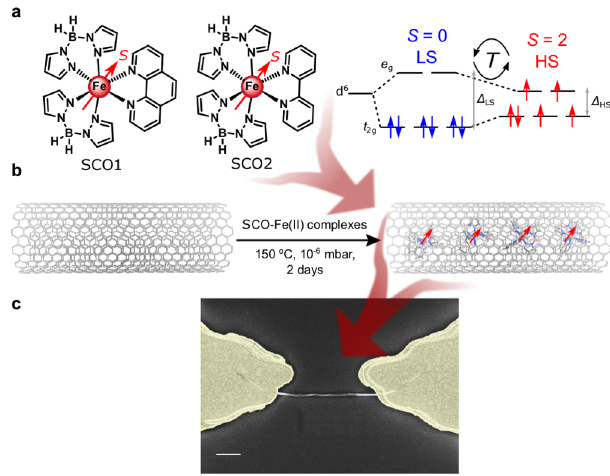
Fig. 1 Encapsulation of SCO complexes. a Complex SCO1, [Fe (H 2 Bpz 2 ) 2 (phen)] and SCO2, [Fe(H 2 Bpz 2 ) 2 (bipy)] encapsulated in this work. Spin ( S ) level distribution in the high (HS) and low (LS) spin states of the molecules. b Schematic pathway for the encapsulation of Fe (II) SCO complexes in oSWCNTs, resulting in SCO@SWCNT. c Scanning electron microscopy (SEM) image of a transistor-like device containing a SCO2@SWCNT heterostructure trapped by dielectrophoresis. Scale bar: 500